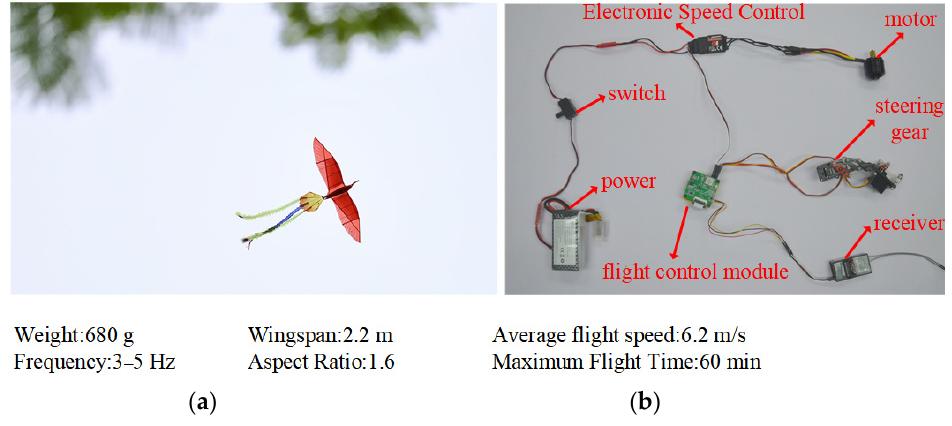
Figure 1. The characteristic parameters and flight control hardware connection of the ”Phoenix” flapping wing robot. ( a ) Flapping wing robot and its characteristic parameters. ( b ) flight control hardware connection.